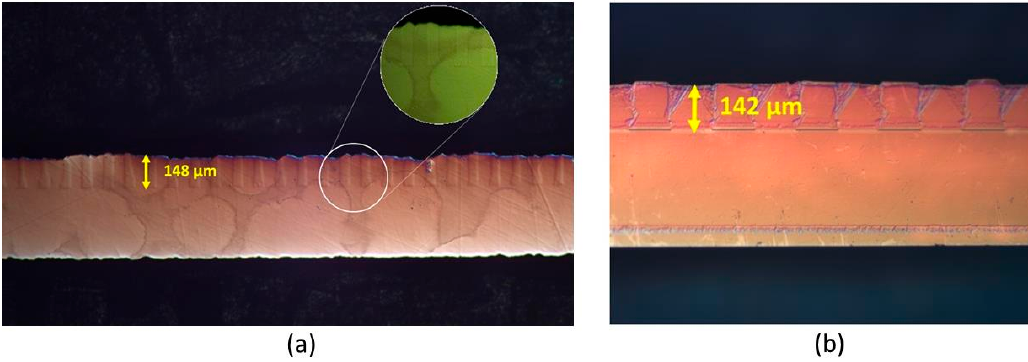
Figure 25. ( a ) One-hour homoepitaxial growth of OPGaP on OPGaP; ( b ) A four-hour homoepitaxial growth indicates that roughening of the layer surface and overgrowth of the pattern may occur at longer experimental times [63]. (Reproduced from [63] with the permission of SPIE).